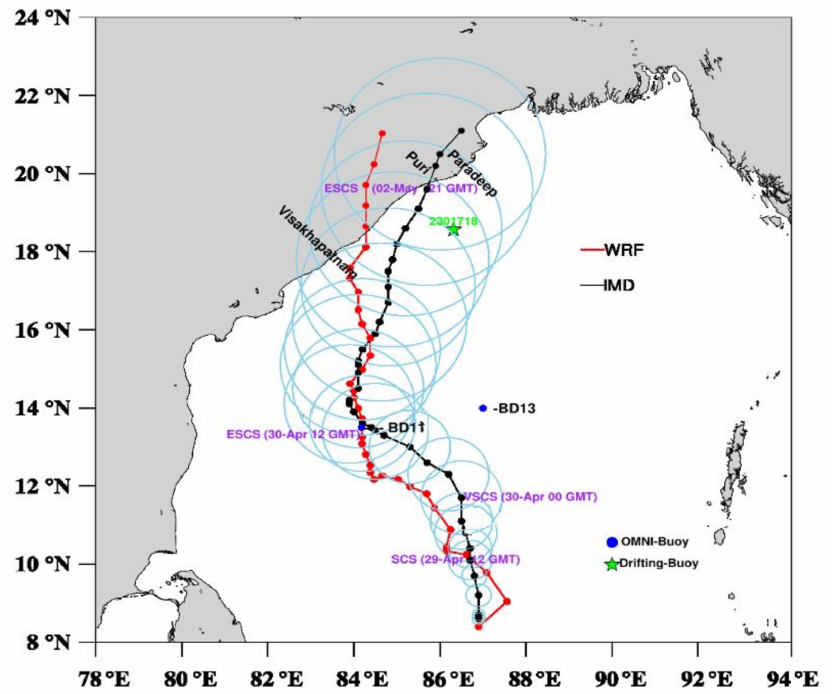
Figure 3. Model computed Fani cyclone track (00 GMT on 29 April to 00 GMT 3 May) along with IMD best-track. Locations of buoys are marked with different symbols and colours. The light blue circle represents the cone of uncertainty at different hours from IMD